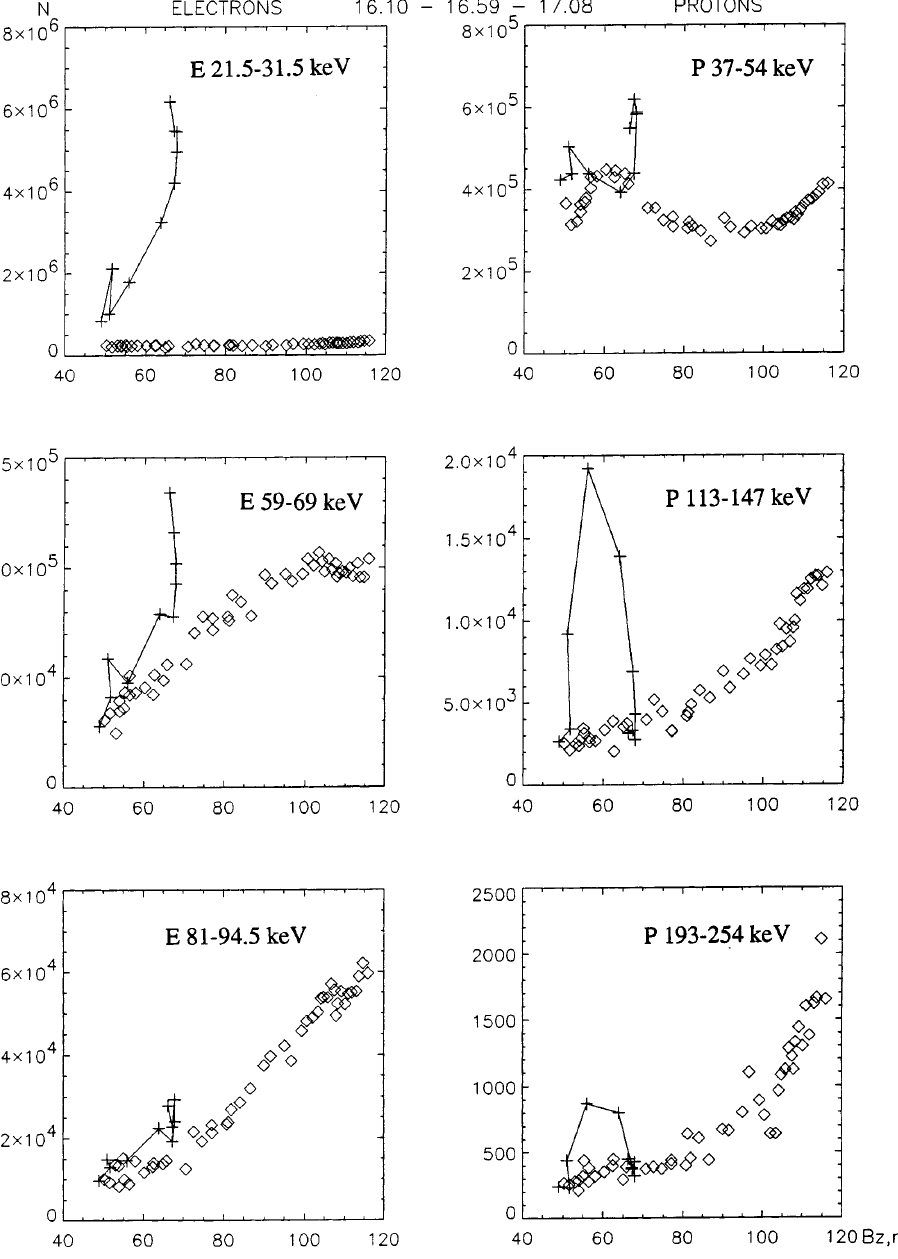
Fig. 7. The particle intensities during the growth phase ( the diamonds ) and the first minutes of the active phase ( the pluses ) as a function of B 2 . Left column , trapped electrons; right column , protons. Units are in cm (cid:255) 2 s (cid:255) 1 sr (cid:255) 1 keV (cid:255)